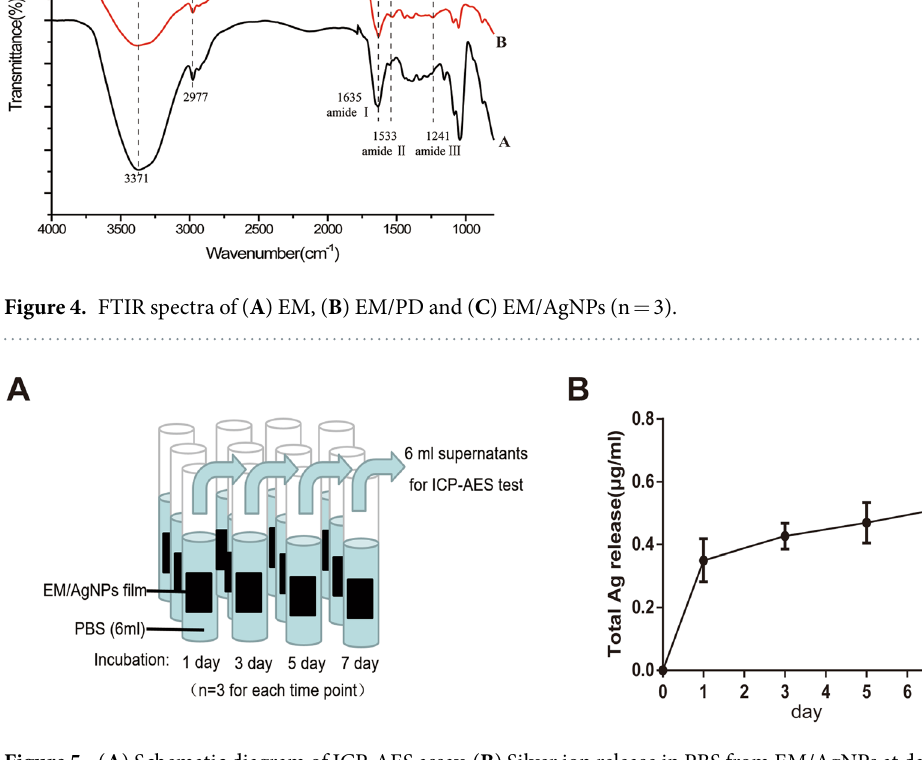
Figure 5. ( A ) Schematic diagram of ICP-AES assay. ( B ) Silver ion release in PBS from EM/AgNPs at days 1, 3, 5 and 7. The values are shown as the mean ± SD (n =